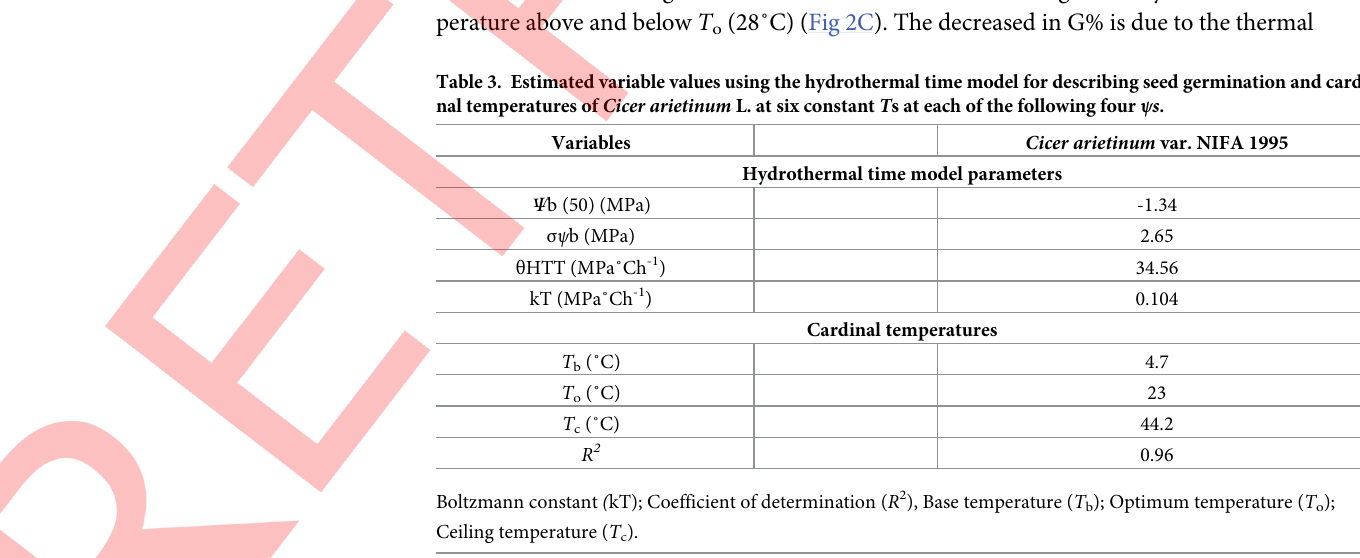
Table 3. Estimated variable values using the hydrothermal time model for describing seed germination and cardi- nal temperatures of Cicer arietinum L. at six constant T s at each of the following four ψs